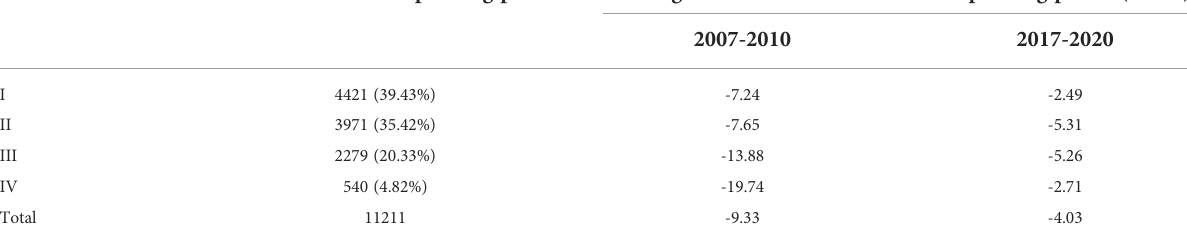
TABLE 2 Statistics of corresponding points and subsidence value in reclamation zone. Reclamation